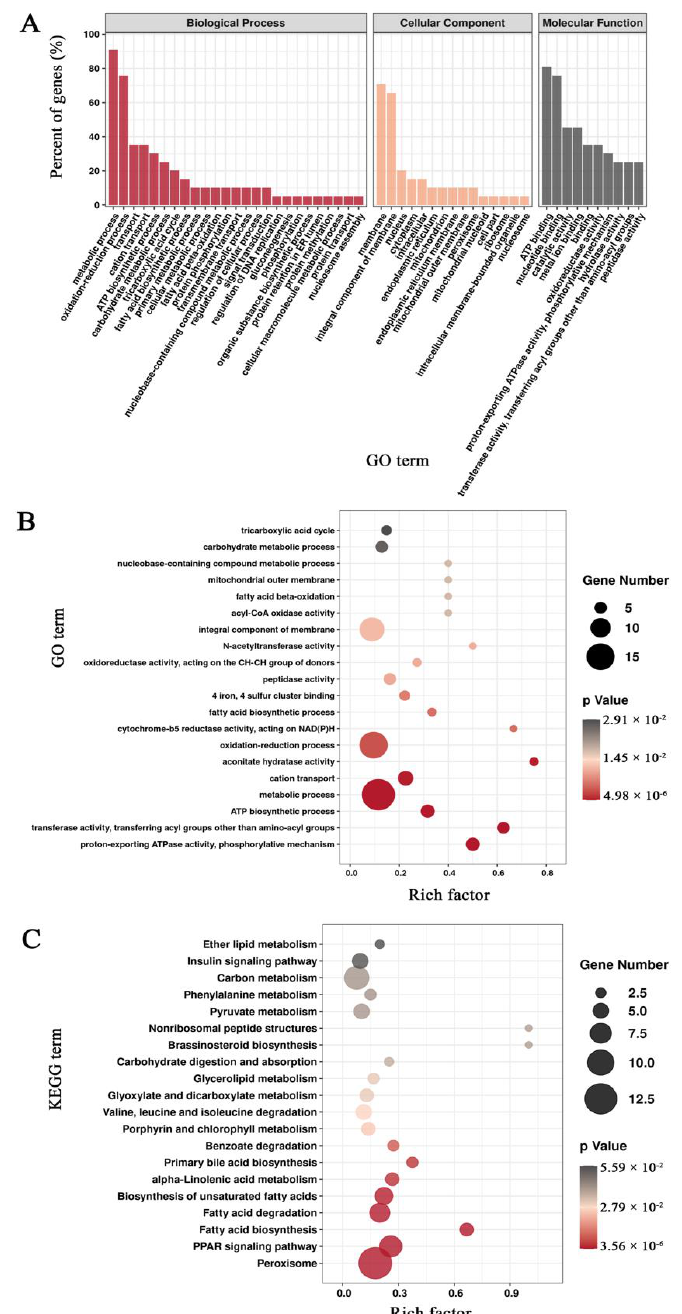
Figure 7. GO ( A , B ) and KEGG ( C ) enrichment analyses of differentially expressed genes (DEGs) derived from the TB vs. TC comparison of Mortierella alpina .